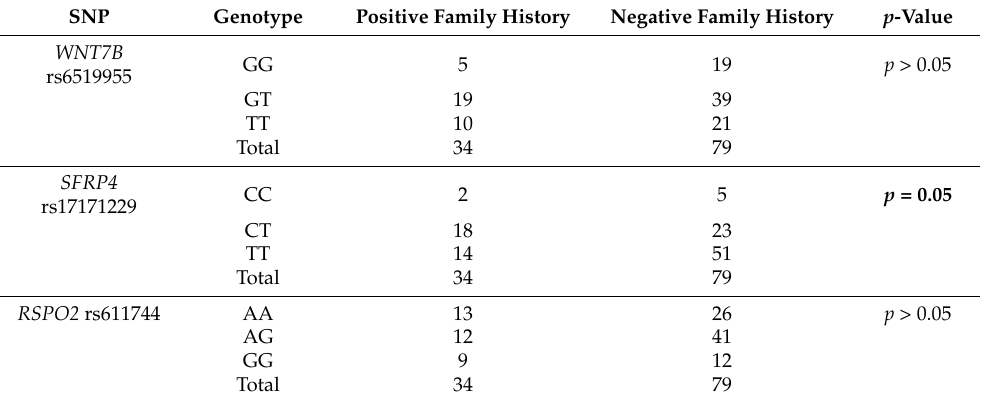
Table 4. Distribution of WNT7B rs6519955, SFRP4 rs17171229 and RSPO2 rs611744 genotypes in the DC group by